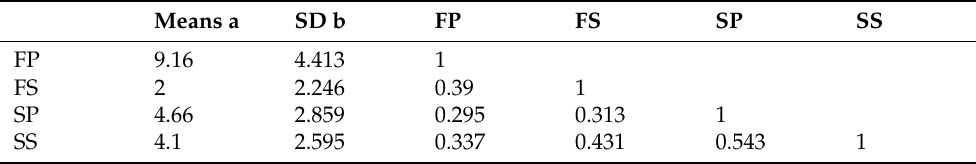
Table 4. Means, standard deviations, and correlations.